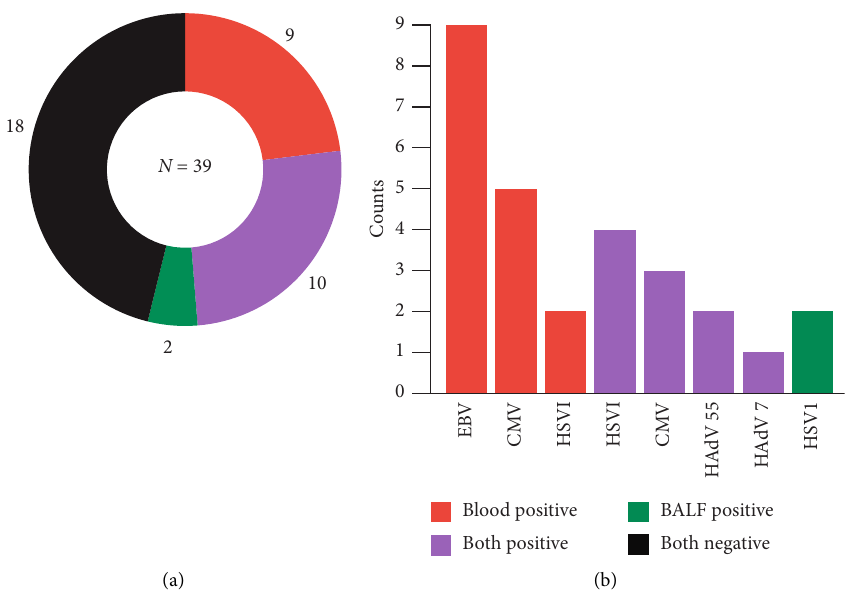
Figure 2: Blood and BALF mNGS for viral detection. (a) The mNGS results for viral detection in 39 patients.18 patients (black) had negative results in both blood and BALF mNGS. Viruses were detected in 21 patients, among whom 10 patients (purple) had positive results in both blood and BALF mNGS, 9 patients (red) had positive blood mNGS results, and 2 patients (green) had positive BALF mNGS results. The number of cases and percentage of different conditions are listed near the plot. (b) The distribution of pathogens identified by blood mNGS and BALF mNGS. Abbreviations: mNGS, metagenomic next-generation sequencing; BALF, bronchoalveolar lavage fluid; EBV, Epstein- Barr virus; CMV, Cytomegalovirus ; HAdV, human